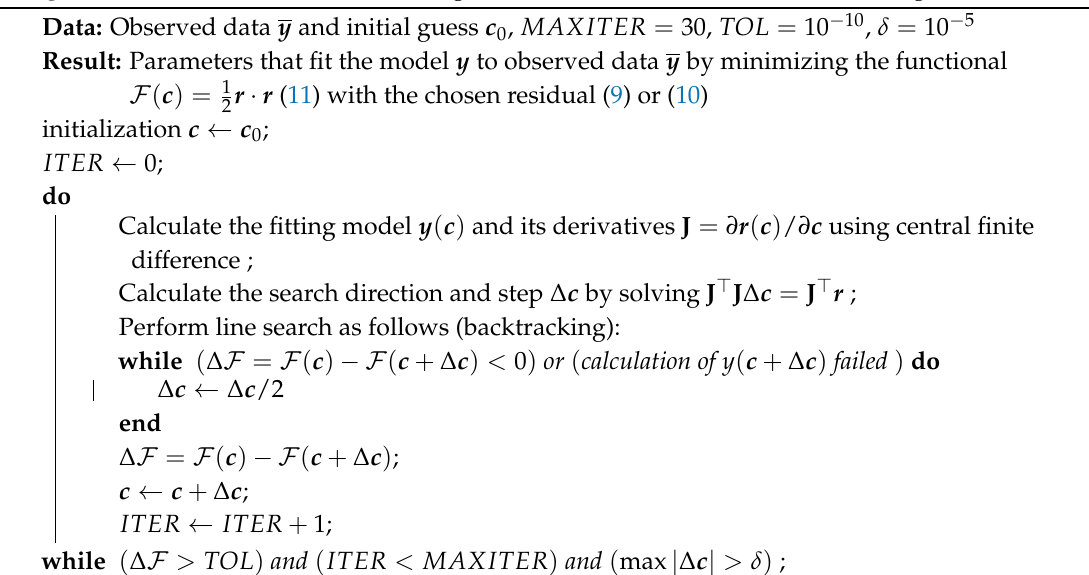
Algorithm 1: Parameter estimation using Gauss-Newton method with backtracking line search.